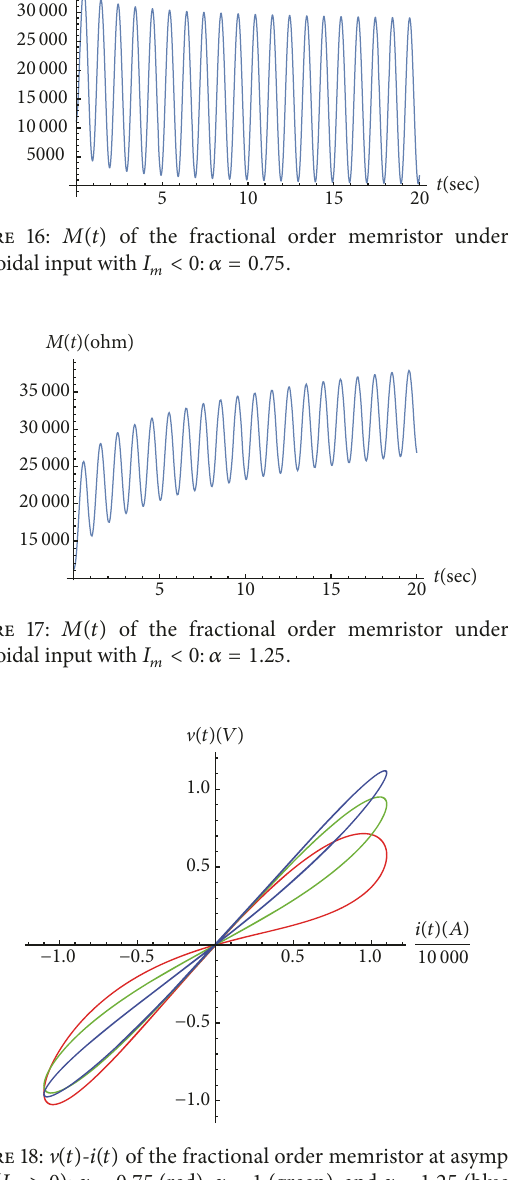
Figure 18: V (𝑡) - 𝑖(𝑡) of the fractional order memristor at asymptotic state ( 𝐼 𝑚 > 0 ): 𝛼 = 0.75 (red), 𝛼 = 1 (green), and 𝛼 = 1.25 (blue).